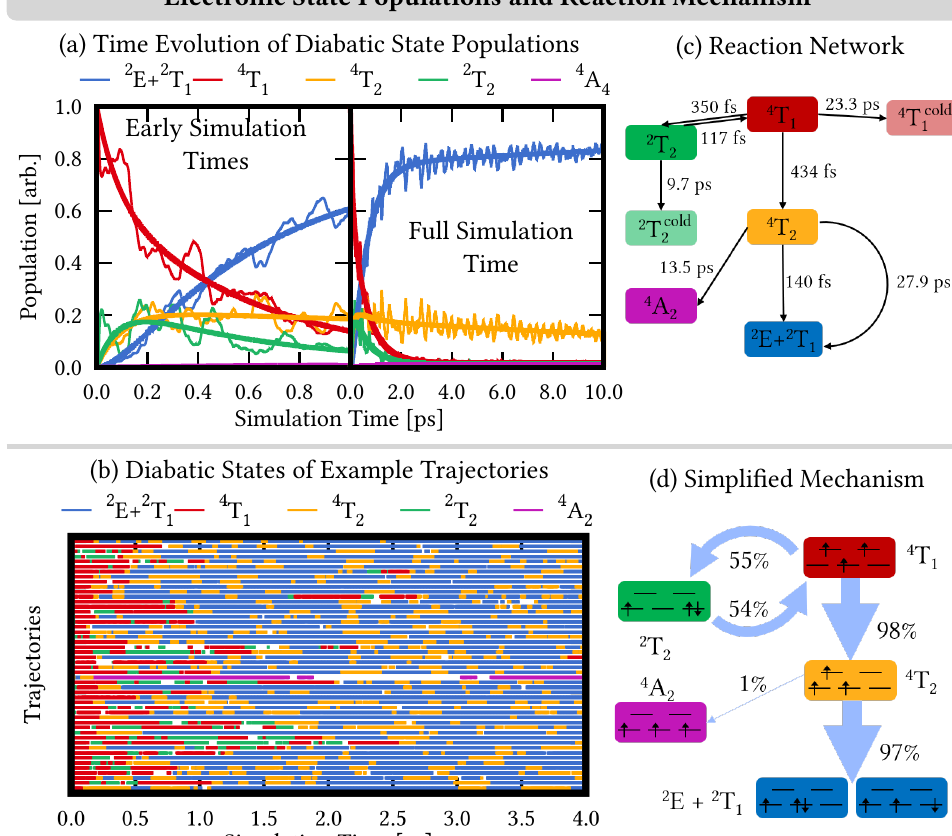
Figure 4. ( a ) Time evolution of the diabatic electronic state populations (thin lines) of states combined into terms according to Figure 2. Thick lines represent fitted population curves according to the reaction network in ( c ). ( b ) Time evolution of 50 example trajectories. The trajectories are colored according to their dominant diabatic state contribution if it exceeds 80% of the wave function character. ( d ) Simplified reaction mechanism following the reaction network in ( c ). The thickness of the arrows connecting the electronic terms corresponds to the contribution of their pathway to the